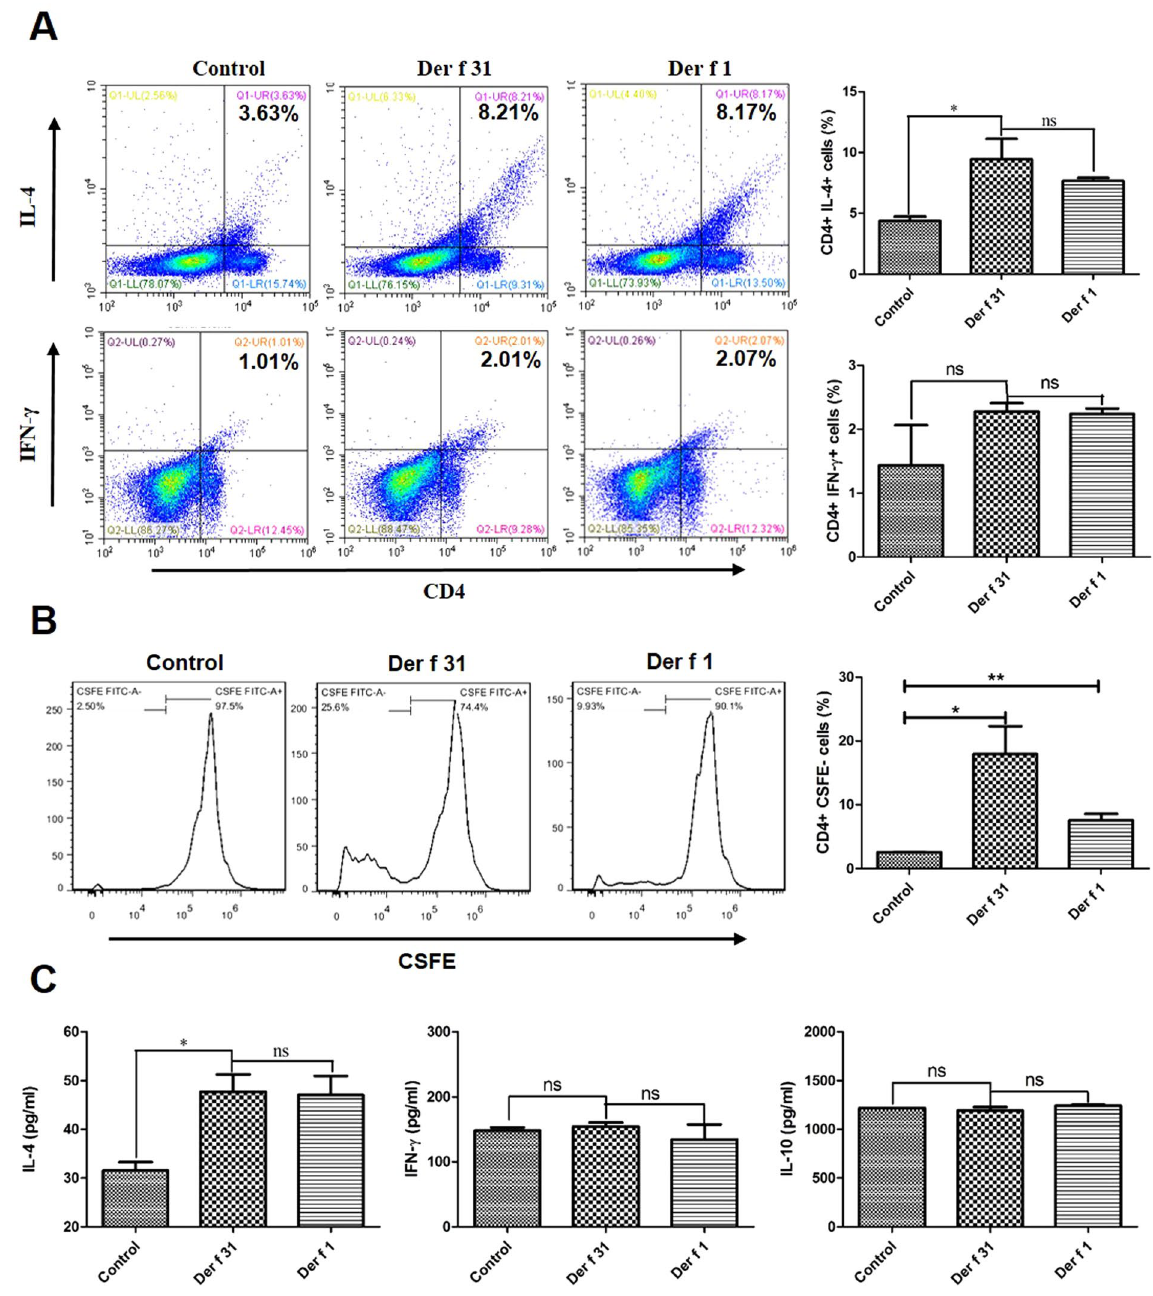
Figure 5. Der f 31 induces Th2-type response in spleen. The spleen cells were cultured with Der f 31 and Der f 1 for 3 days, then analyzed by FACS. ( A ) The different subtypes of T helper cells. ( B ) The proliferation of CD4 + T cells in the spleen. ( C ) The cytokines in the spleen cell supernatant. These data (means ± SEMs) were generated from one of three experiments (n = 6), processed with GraphPad software. The significant differences between two groups were tested by two-tailed T-test. ** p < 0.01. *** p < 0.001. ns, no significant